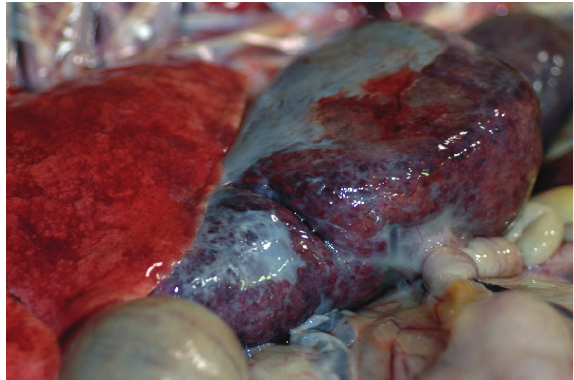
Figure 1: The liver has prominent rounded edges and a thick fibrous